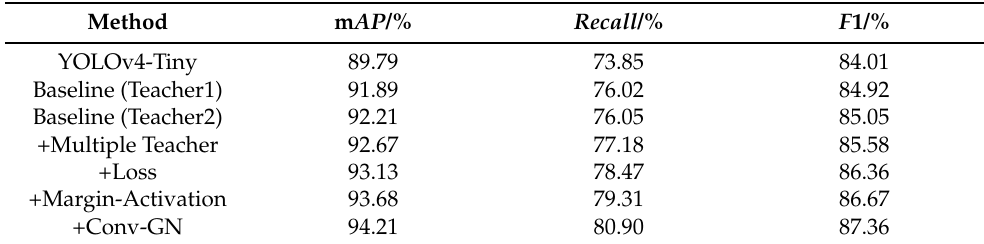
Table 4. Results of ablation